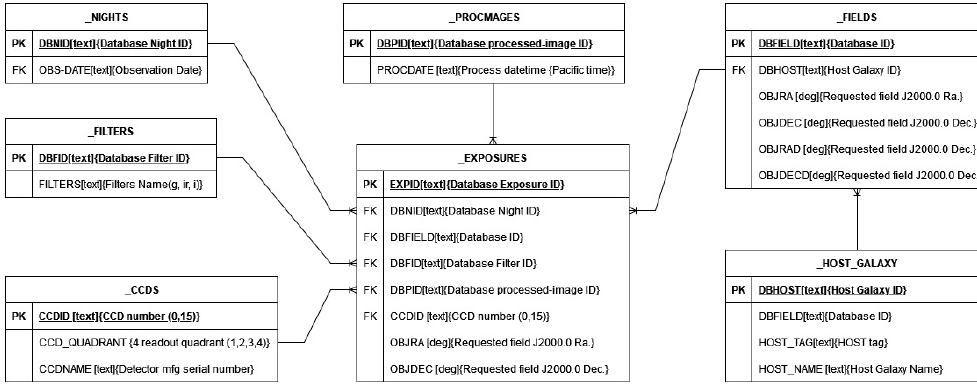
Figure 3. ER Model of the Database with Relations and